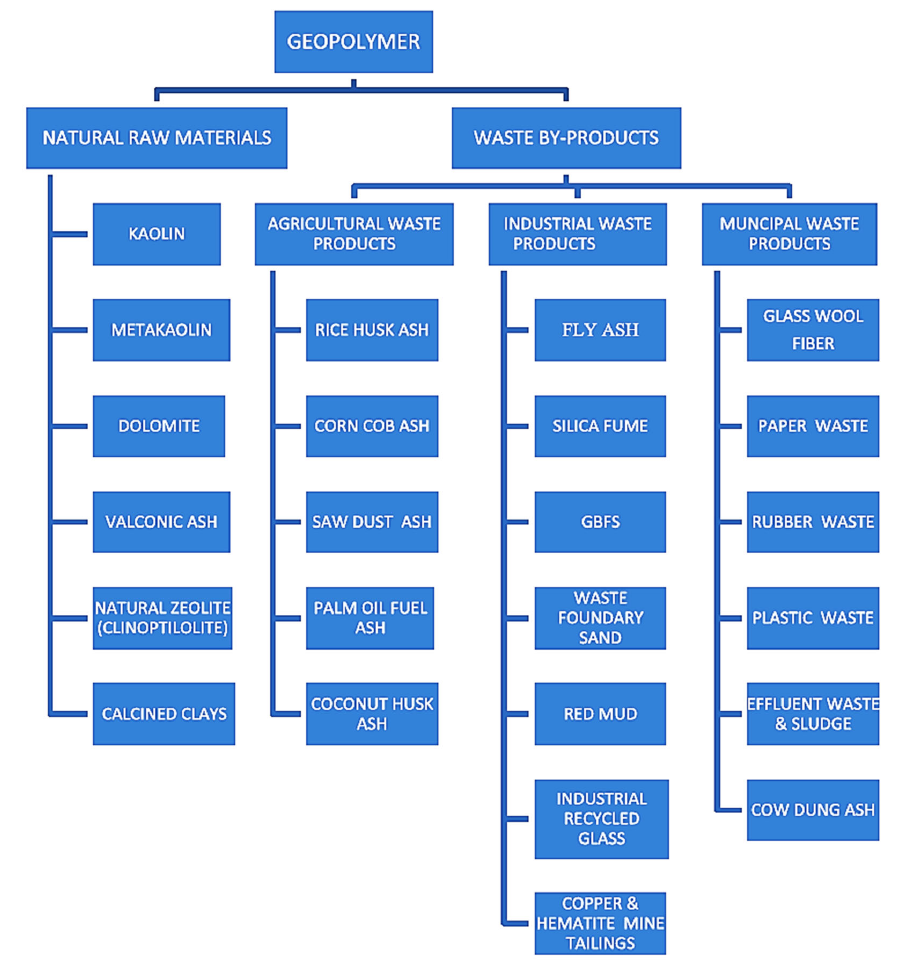
Figure 2. Precursor materials that are commonly utilized in GP composites. Adapted from [34].